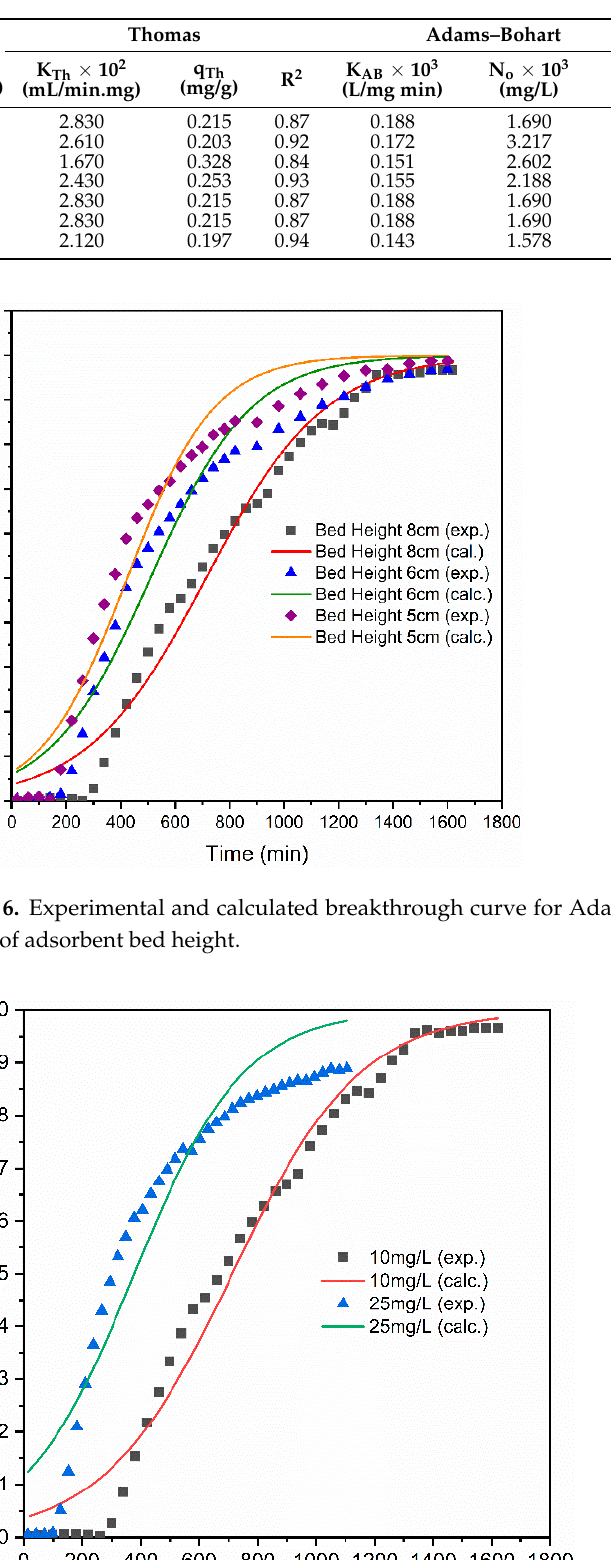
Table 2. Parameters for Thomas, Adam–Bohart, and Yoon–Nelson models at different parameters.